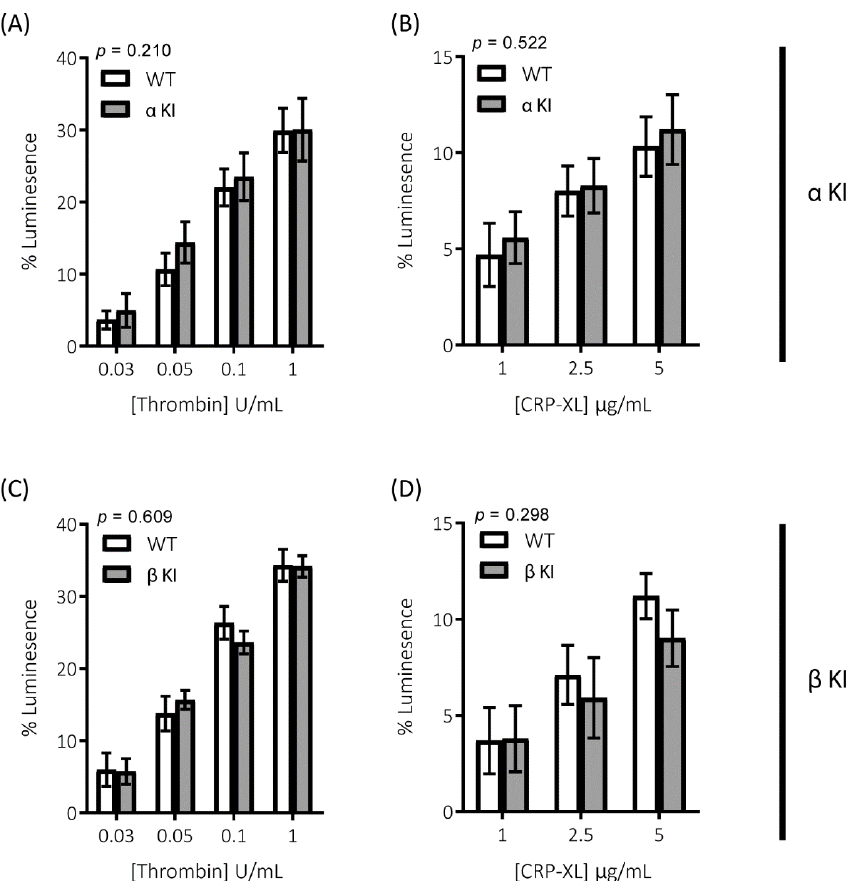
Figure 5. Secretion of the δ -granule cargo ATP is unaltered in platelets expressing phosphorylation-resistant GSK3 α or GSK3 β . ATP secretion from platelets was monitored using CHRONO-LUME ® and the Infinite ® 200 PRO multimode reader (TECAN, Reading, UK). Platelets from α KI mice had no significant alterations in ATP secretion in response to ( A ) thrombin or ( B ) CRP-XL ( n = 5). Platelets from β KI mice had no significant alterations in ATP secretion in response to ( C ) thrombin or ( D ) CRP-XL ( n = 5). A 2-way ANOVA (Variable 1 = genotype, Variable 2 = concentration of agonist) was used to test for differences between groups. Data are the peak luminescence expressed as a % of luminescence signal evoked by a fixed concentration of ATP.